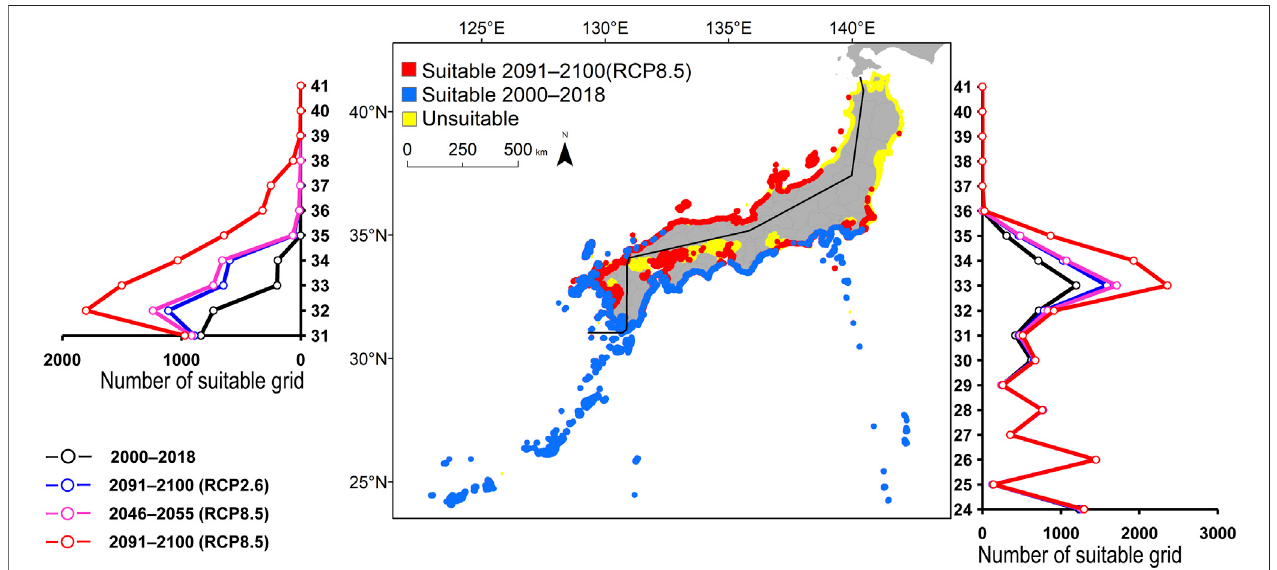
FIGURE 7 | Estimated distribution of Chaetodon auriga . See Figure 2 for the explanation.